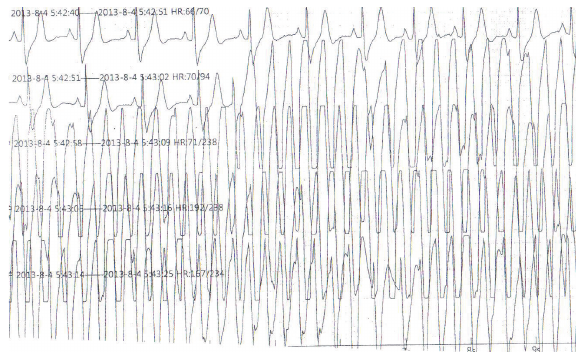
Figure 2: ECG record during attack at 5:42 a.m. on August 4, 2013.